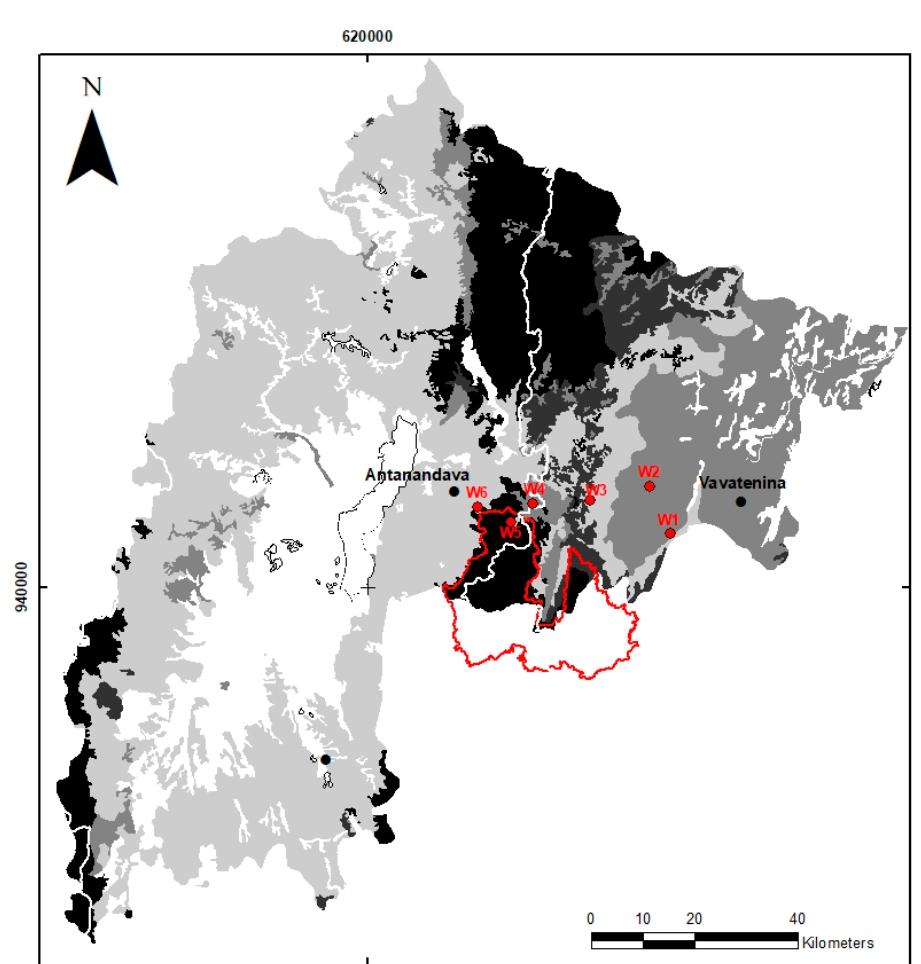
Figure 1. Study area within the Maningory watershed, with locations of the six game workshops (W1–6). Humid dense forest (black), degraded forest (dark grey), agricultural matrix (grey), and grasslands, including wooded grasslands (light grey), other land types such as water bodies, wetlands, and irrigated rice fields (white). Contours in red show National Park boundaries of Zahamena, and grey delimits Lake Alaotra, where other interviews to this research were conducted. The white north–south dividing line is the political boundary between the two districts, Analanjirofo in the east and Alaotra-Mangoro in the west. Land types are based on Landsat imagery classification using Labord projection (LC8158072_0722014236; LC8158073_0732014236; LC8159072_0722014259 Courtesy of the United States (US) Geological